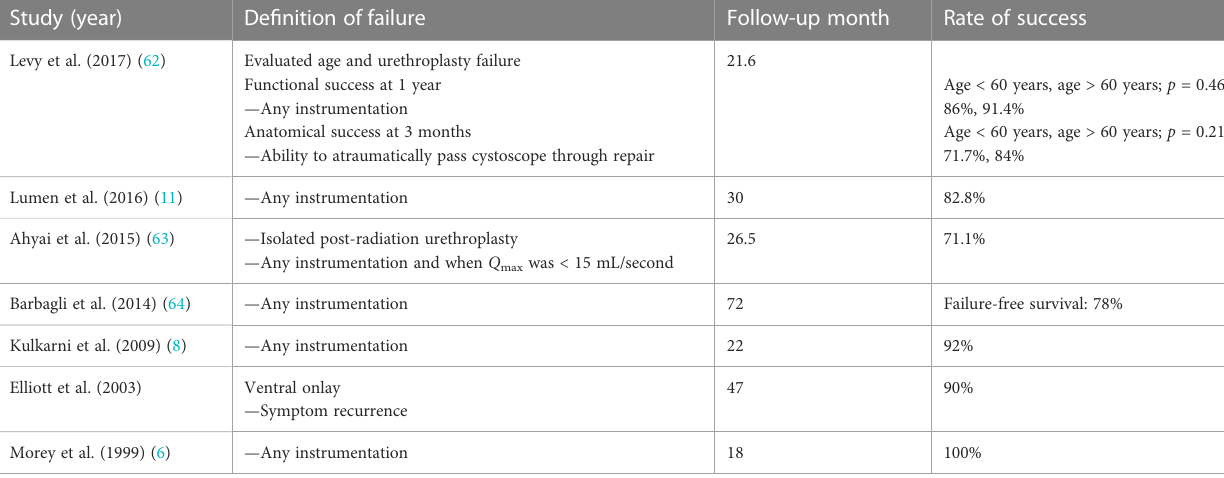
TABLE 4 Rates of urethral stricture recurrence and de fi nitions of